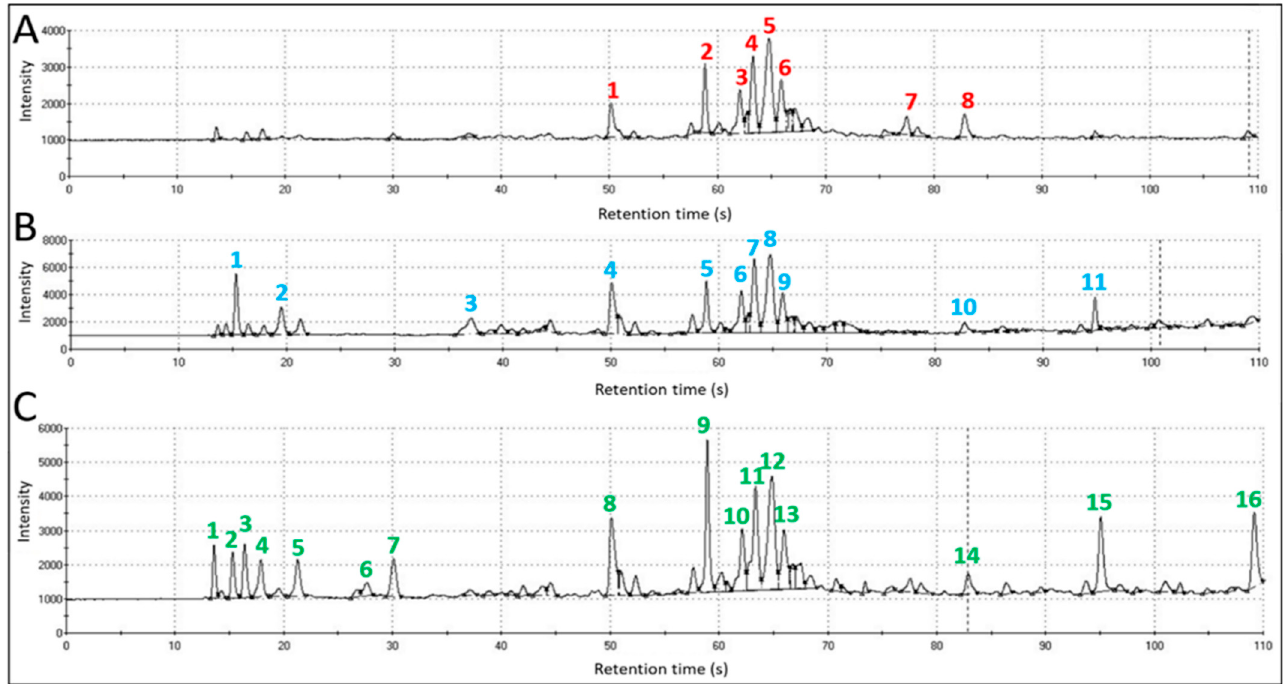
Figure 2. Gas chromatograms, derived from DB-5 column, displaying numbered major peaks detected in whole-body VOC emissions from P. subflavus bats. ( A ) Pd-infected cave bats = Pd-infected, WNS-symptomatic torpid bats with reduced physiologically activity, but with more frequent arousal episodes due to dermatophytic, Pd-associated irritation ( B ) Healthy cave bat = physically inactive, Pd-uninfected, torpid bats with greatly reduced physiological activity; and ( C ) Healthy field bats = physically active foraging bats with full-range of metabolic activities.